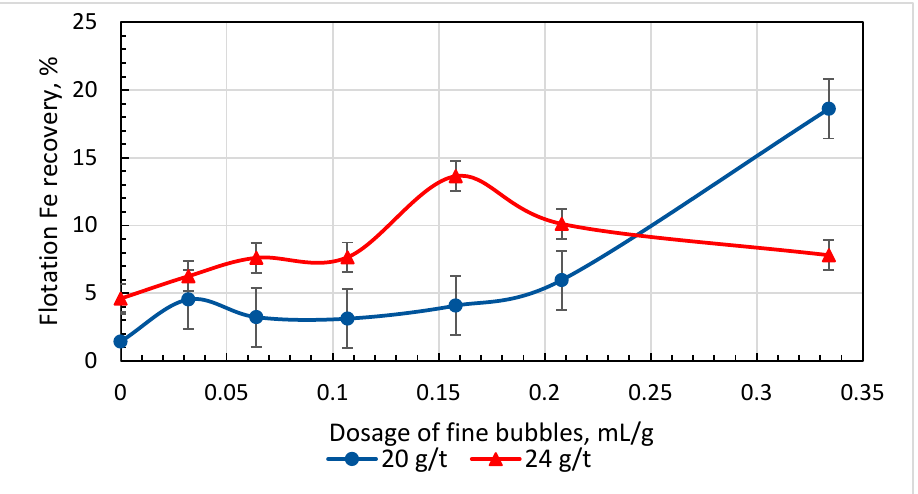
Figure 7. Dependence of the share of flotation recovery of iron in tailings (froth product) on the fine bubble dosage for CTAB consumptions of 20 and 24 g/t. Treatment time in a tubular reactor 7.5 s. TFR inner diameter is 6 mm. Coefficient of the hydraulic entrainment of iron k Entr = 0.9, coefficient of pulp dilution in column k s =